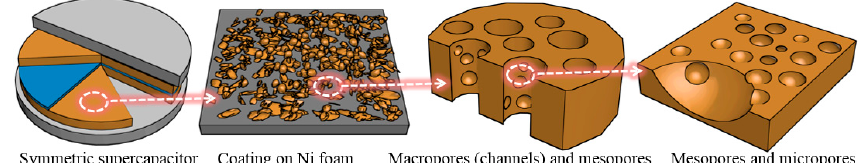
Figure 1. Schematic illustration for the hierarchical porous structures of corncob-derived carbon.